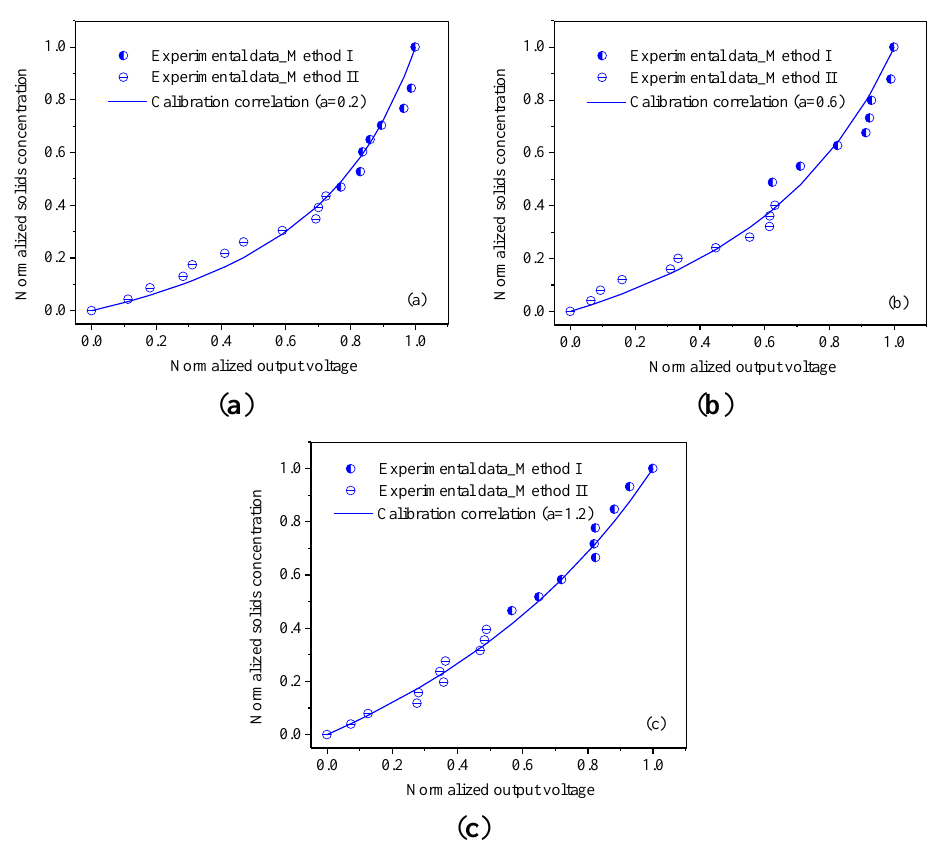
Figure 8. Calibration curves for Quartz sand: ( a ) QS 1#; ( b ) QS 2#; ( c ) QS